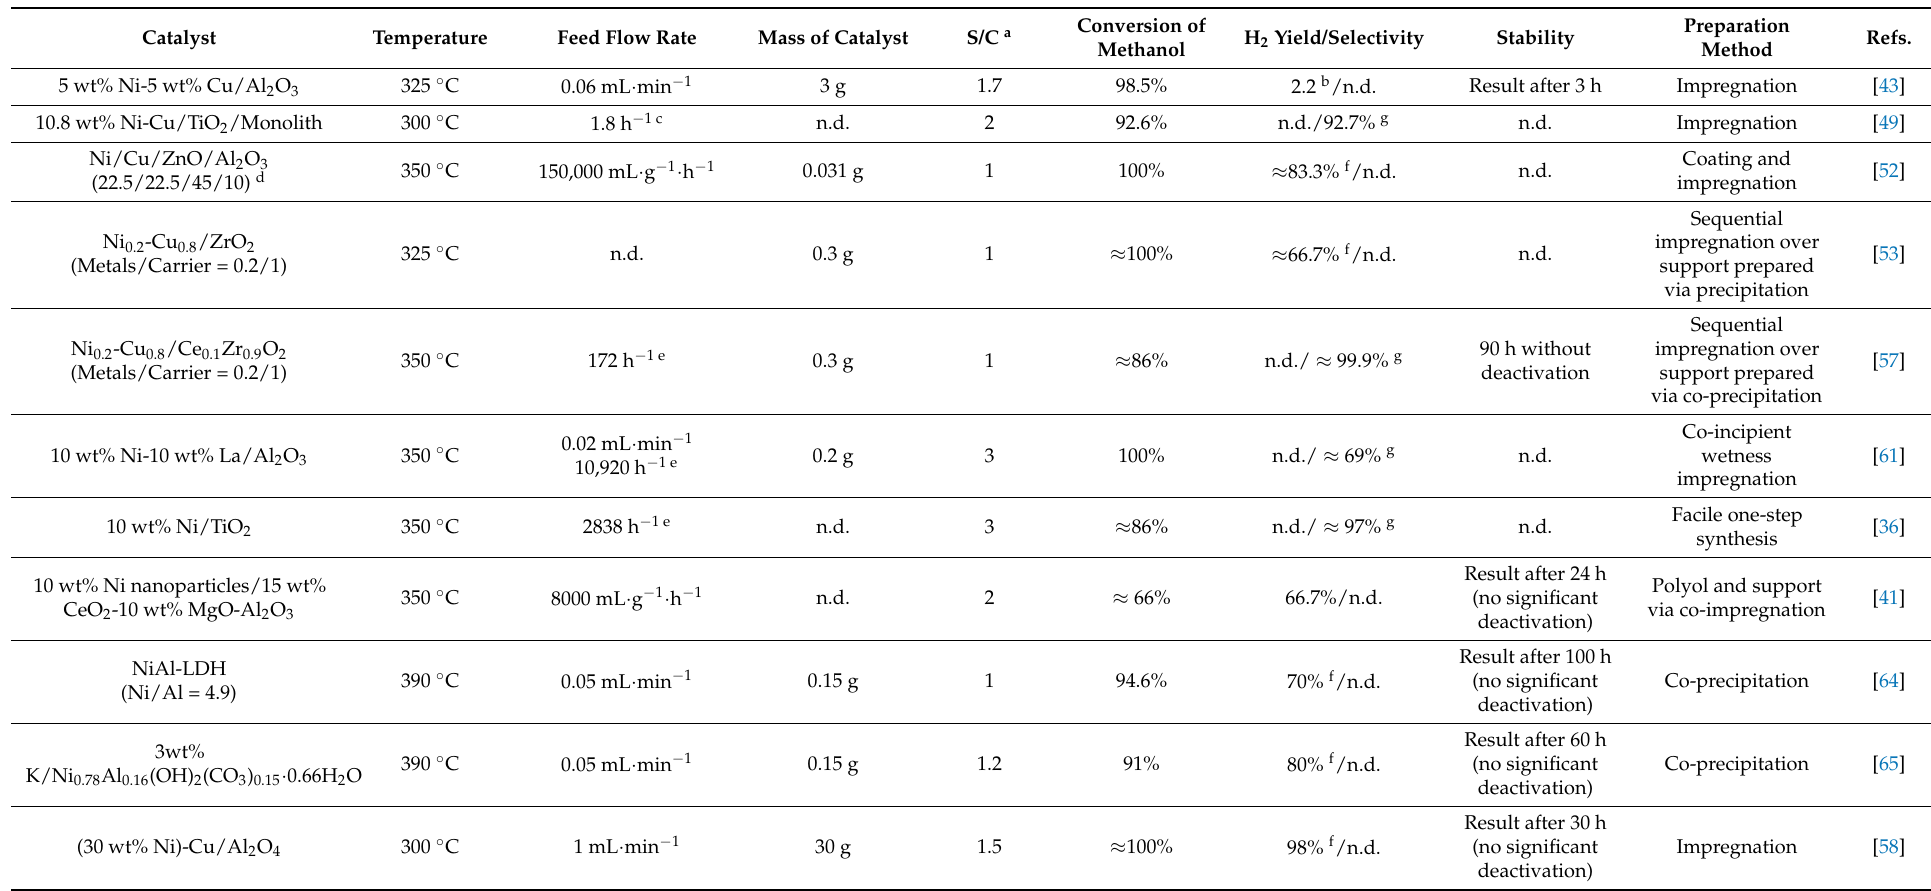
Table 1. Comparison of some of the most promising MSR catalysts reviewed in this